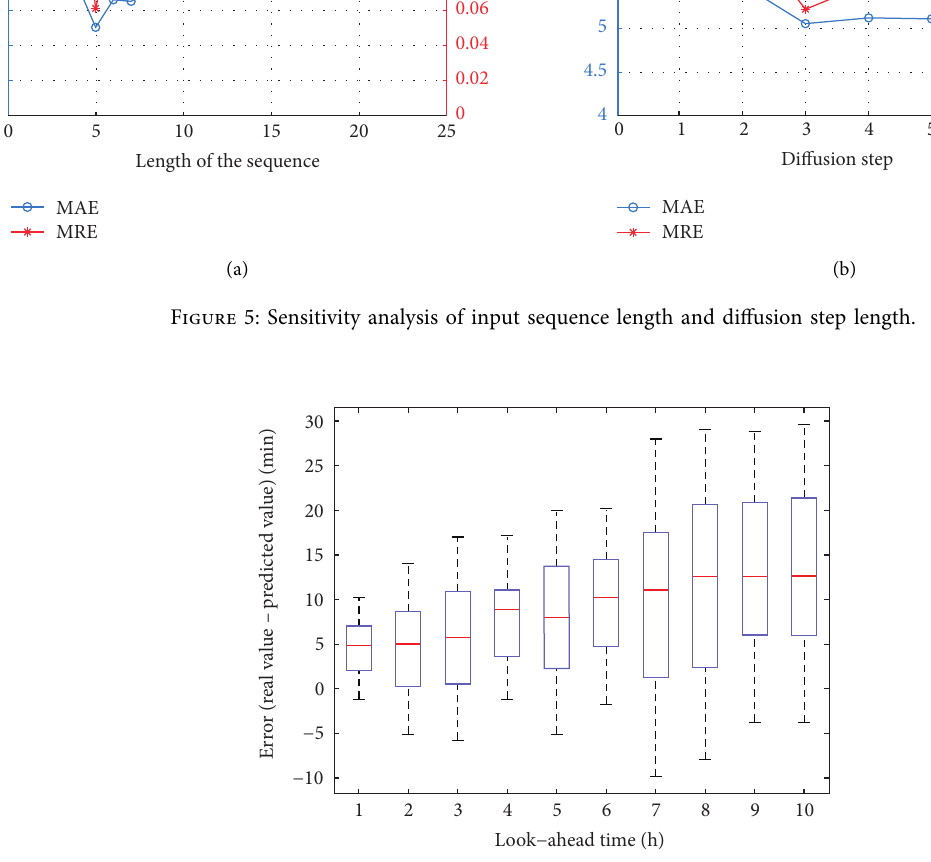
Figure 6: Prediction error of DGLSTM as a function of varying look-ahead